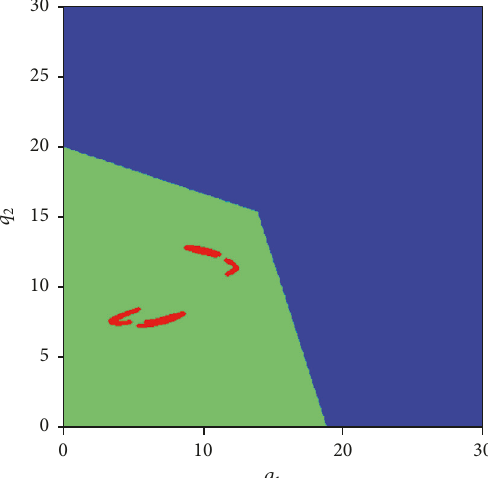
cycle. In Figure 27, when 𝛼 = 0.3 , 𝛽 = 0.25 , and 𝑞 3 = 7 , the system is in chaos. In Figure 28, when 𝛼 = 0.3 , 𝛽 = 0.1 , and = 5 , the system is in 4-period cycle. In Figure 29, when 𝑞 3 = 5 , the system is in 𝛼 = 0.3 , 𝛽 = 0.25 , and 𝑞 3